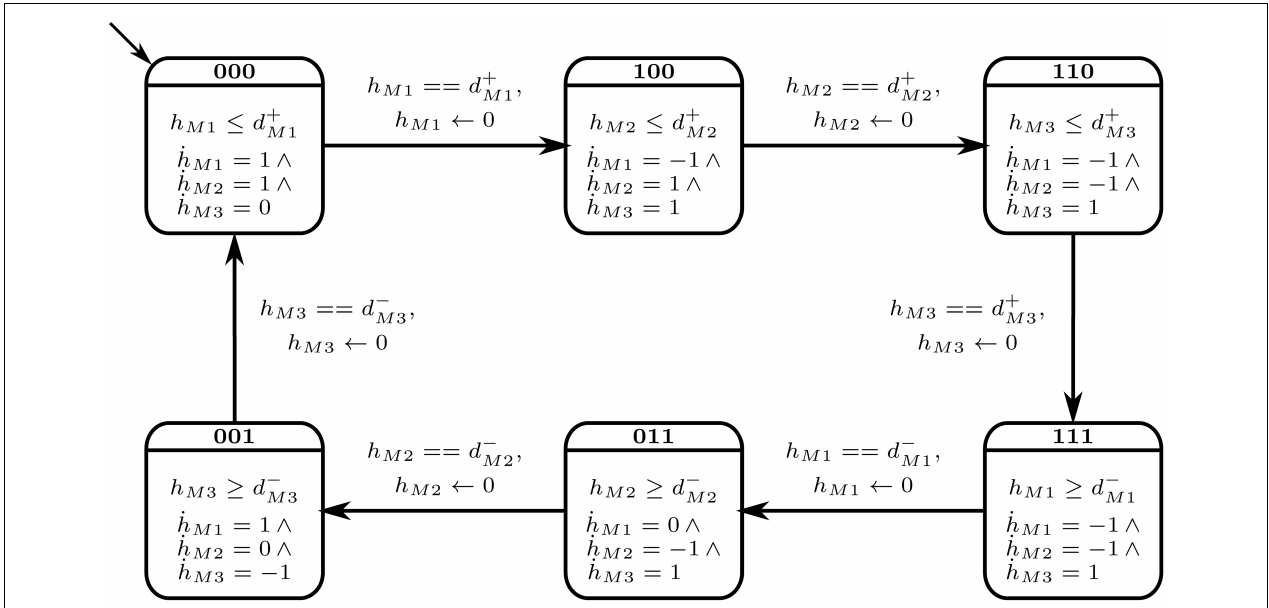
FIGURE 5 | Bio-LHA of Case Study 1: Microbial Population.